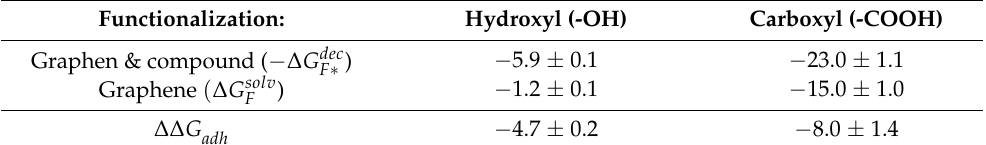
Table 3. Average Gibbs free energies of decoupling and immersion of functional groups on graphene surface with and without adsorbed compound dimer and its effect on adhesion of bis-(Zn) salphen dimers in DCM (kcal/mol). Confidence interval at 95% level for 5 independent simulations. Functionalization: Hydroxyl (-OH) Carboxyl